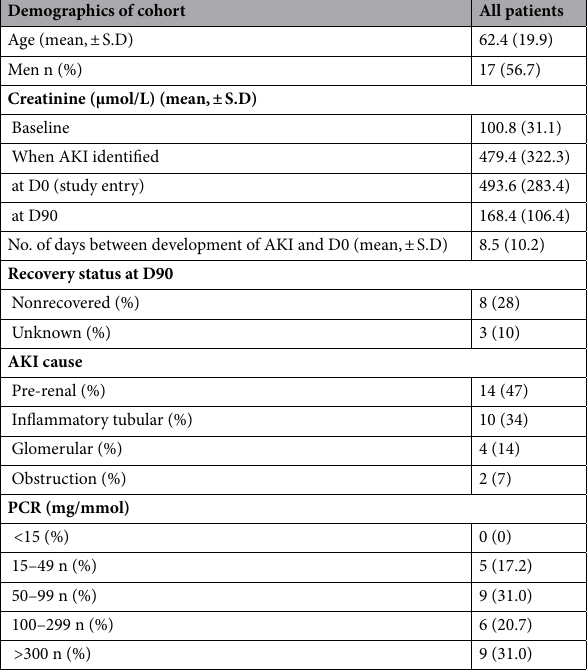
Table 1. Demographic and clinical parameters of patients recruited from Wales Kidney Research Tissue Bank, University Hospital of Wales,